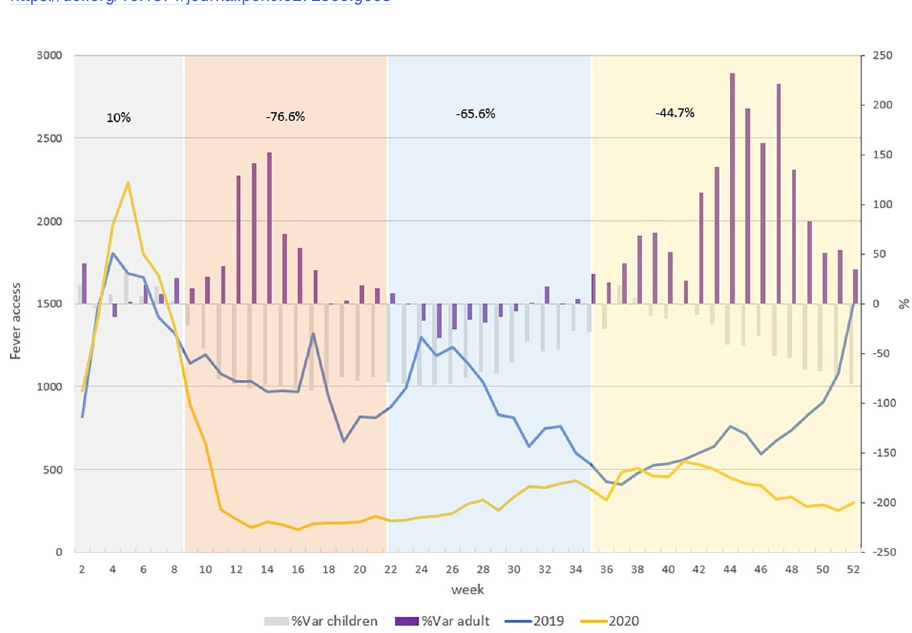
Fig 4. Weekly trend of pediatric access to ED for symptom of fever (2019, 2020). The blue line refers to pediatric ED accesses in 2019 for fever, the yellow line refers to pediatric ED accesses in 2020 for fever. The grey bars indicate the percent variation of pediatric ED accesses for fever in 2020 and 2019 and purple bars indicate the percent variation of ED accesses for fever in 2020 and 2019 for the adult population. Different colours of the time represent the four phases of the pandemic in 2020: Grey = pre-lockdown, orange = lockdown, light blue = post lockdown and yellow = the second wave. In the pre-lockdown period, we found a greater number of accesses in ED with symptoms of fever in 2020 compared to 2019 (+10%). A trend inversion was observed at the beginning of the lockdown period (-76.6%) and continues until the end of the post-lockdown period (-65.6%). At the beginning of the 2 nd wave period, 2019 and 2020 trend are quite similar, but the difference increases in the last weeks of the